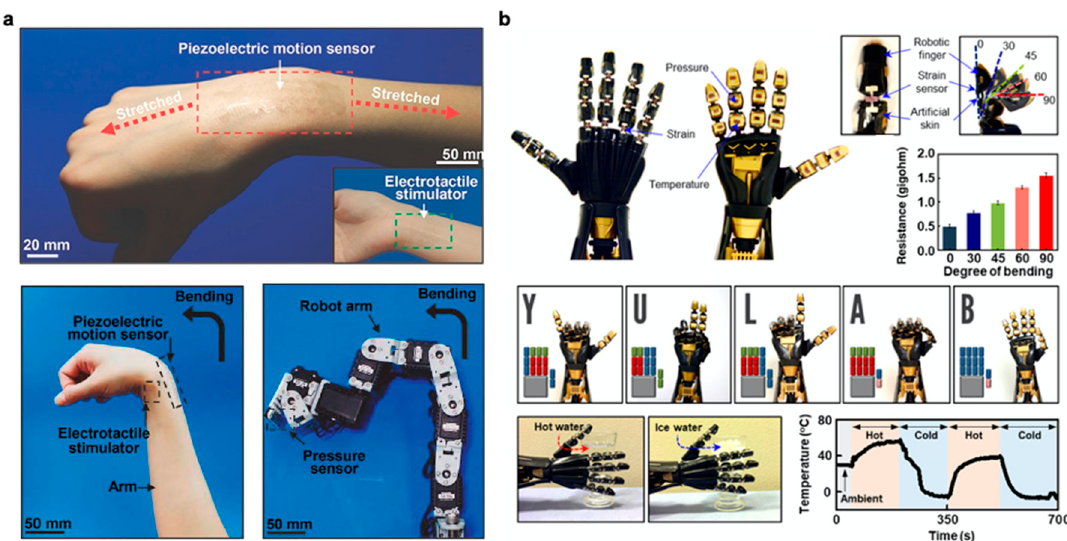
Figure 22. ( a ) Human motion to control a robot arm with corresponding position of the robot arm. Reproduced with permission from [253]. Copyright 2017, John Wiley and Sons ( b ) Demonstration of an intrinsically stretchable rubbery electronics-based robotic skin [254]. Adapted and reproduced with permission as licensed under the Creative Commons Attribution 4.0 International